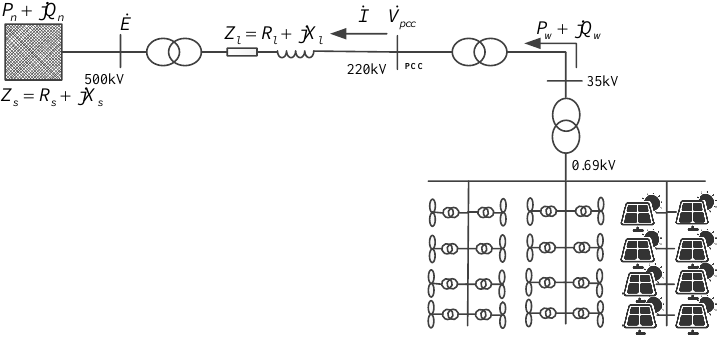
Figure 1. New energy grid connection system.